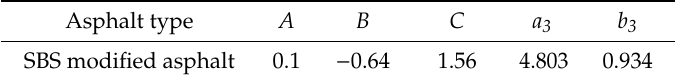
Table 11. Fitting parameters of linear model under di ff erent loading